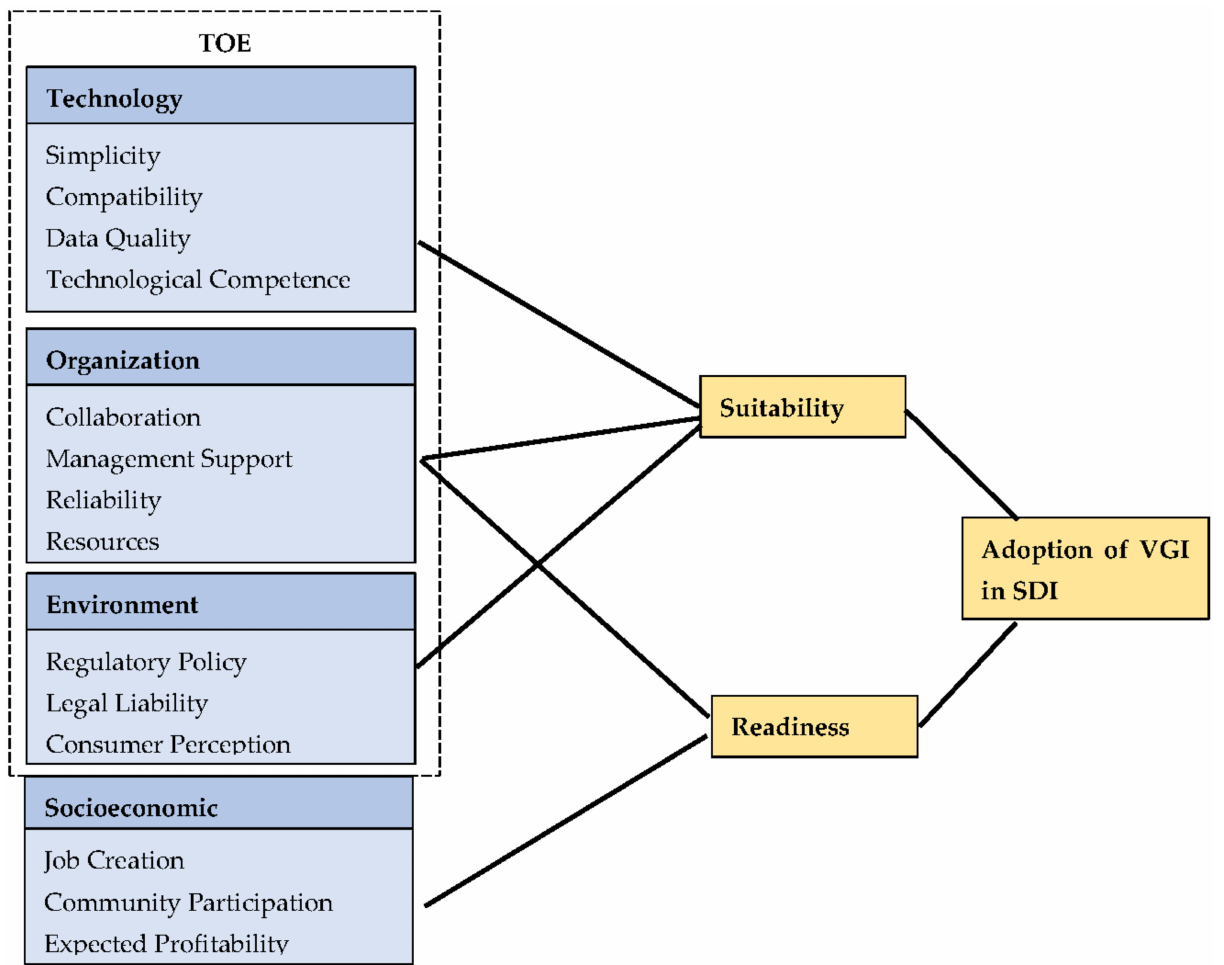
Figure 1. Research